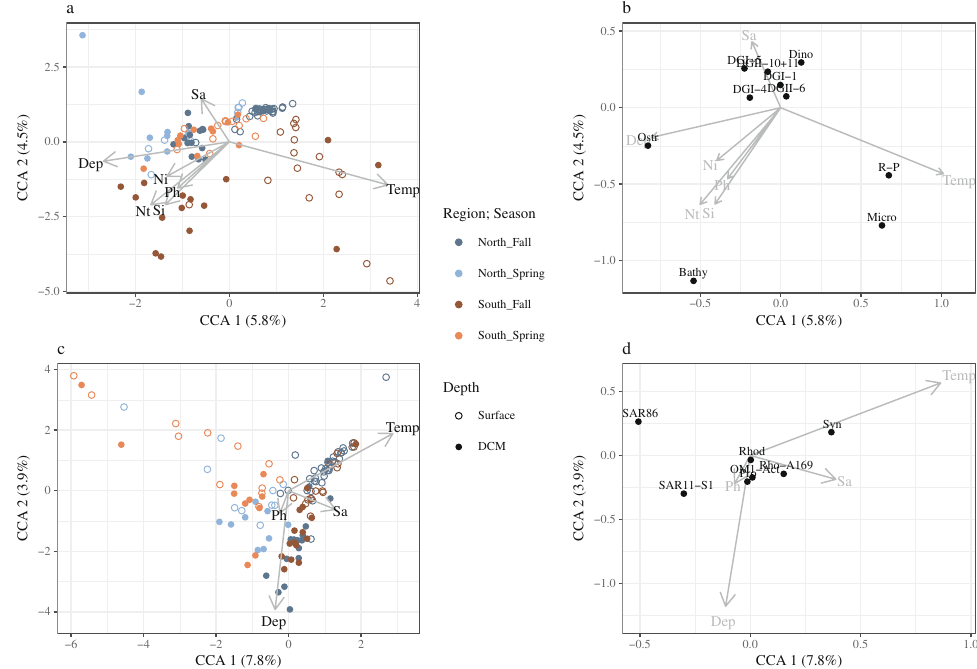
Figure 4. CCA analysis of the eukaryotic stations ( a ) and most abundant eukaryotic groups ( b ) and for